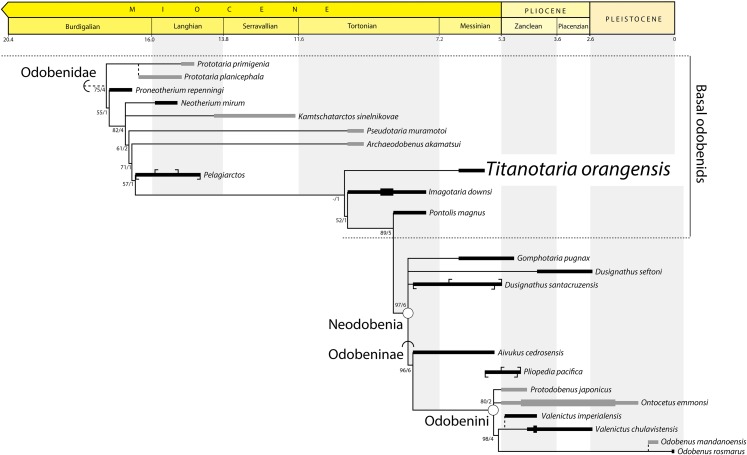
Preferred phylogenetic tree showing position of Titanotaria orangensis n. gen. et sp. (OCPC 11141).A stratigraphically-constrained strict consensus of 27 trees from the analysis with ordered characters. Outgroups (non-odobenids) not shown. Node- (circle) and branch-based (semicircle) phylogenetic names and bootstrap/decay values indicated. The length of ranges indicates age uncertainty for the formation, not taxon duration, with tick marks indicating the limits of specific units. In cases where formation ages do not overlap we show a known range (thick line). Taxa that do not occur in East Pacific formations are dark grey. Non-analyzed congeners indicated by dashed lines, with Pliopedia pacifica placed near the Odobenini. The lineage of Valenictus is extended to accommodate a specimen from the Purisima Formation. Protodobenus japonicus is sister to Odobenini in some trees.